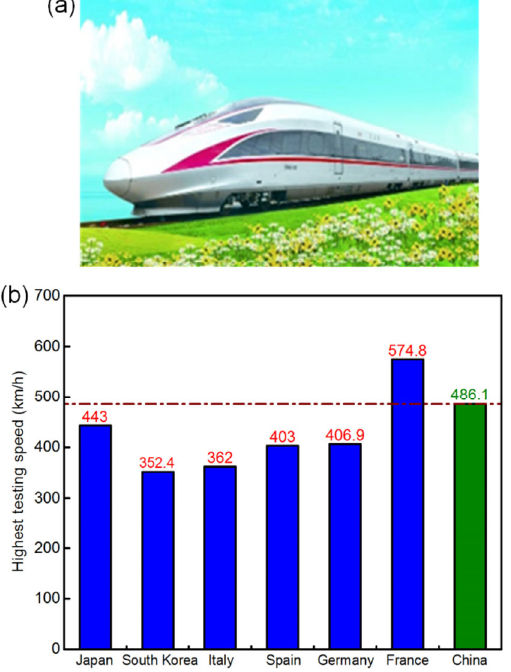
Fig. 11 (a) China Railway High-speed train. (b) Highest testing speed of high-speed trains in different countries.